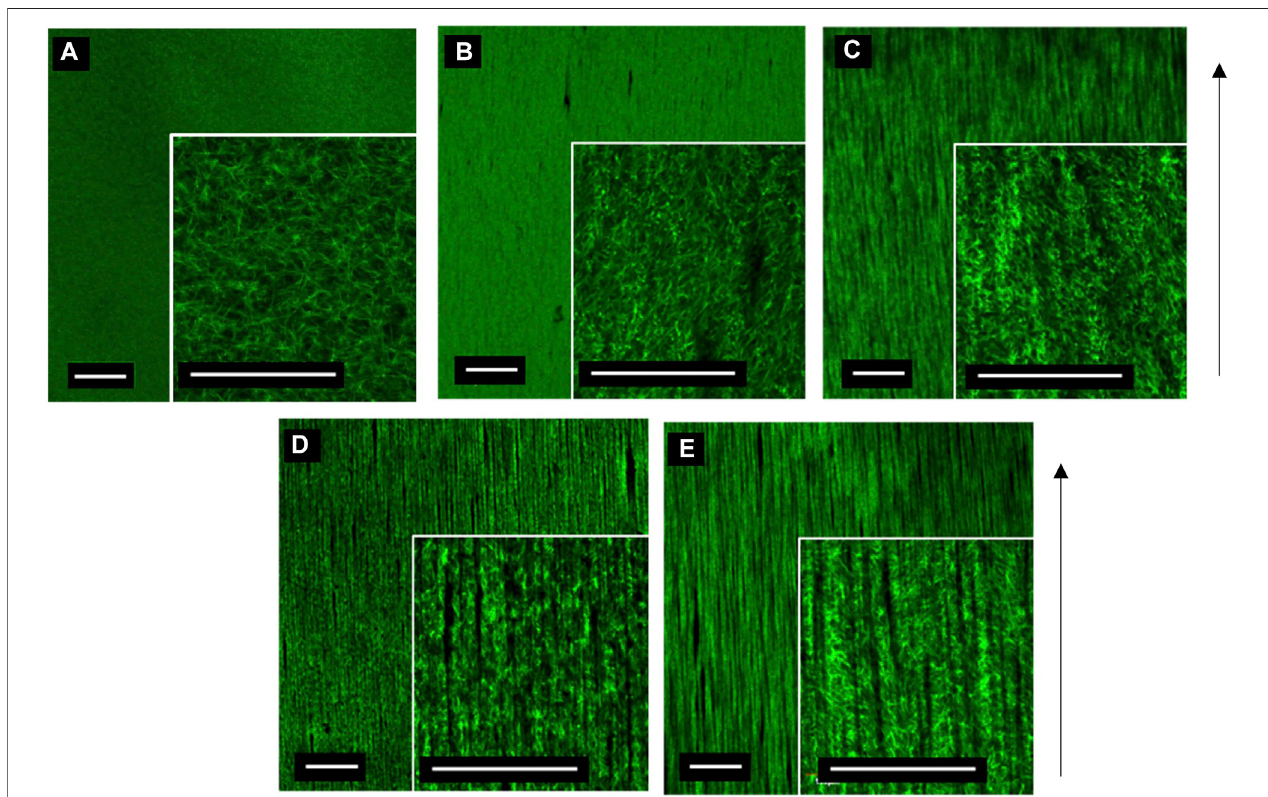
FIGURE5 | Confocal microscopyimages of3 mg/ml collagen hydrogels dosed withcontrol no MNPs (A) , 0.25 (B) , 0.5 (C) , 0.75 (D) , and 1 μ g/ μ l (E) anti-collagen MNPsheld withinamagnetic fi eldfor30 min duringcollagengelation(taken atday 0).Scalebar =0.5 mm,magni fi cation=×4and20×(innerpanels), green=collagenI, arrow = direction of magnetic fi eld lines, and n =